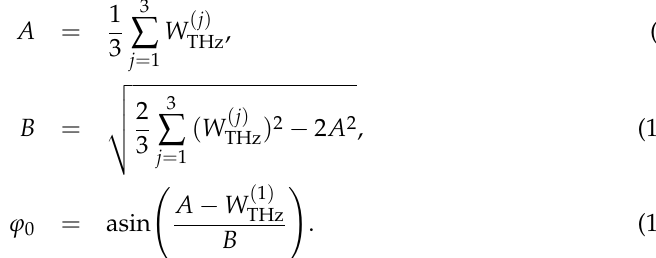
obtained from UPPE simulations THz